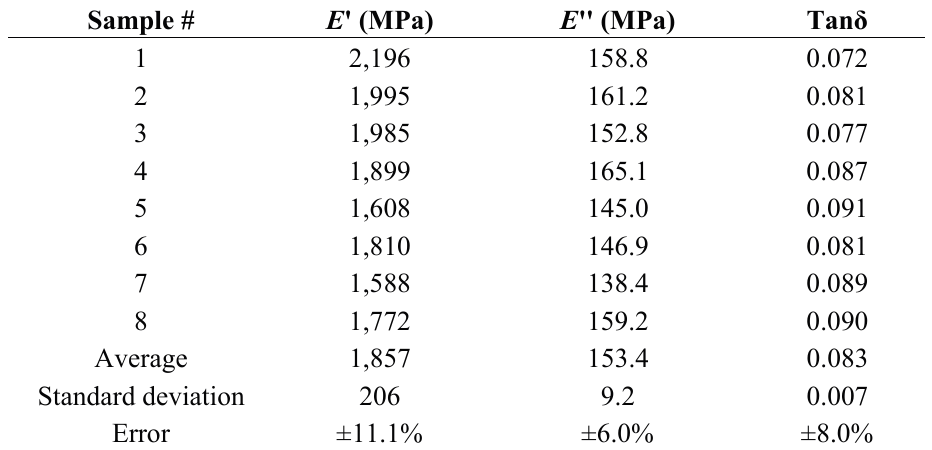
Table 2. E ', E '' and Tan δ of eight independent samples equilibrated at 20 °C and 20% RH for 6